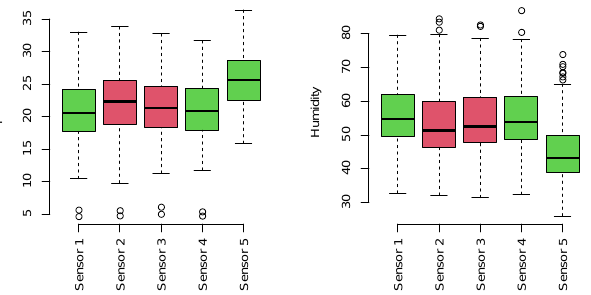
Figure 17. Clustering of O 3 data for the full period of the study and their visualization with respect to temperature and humidity.